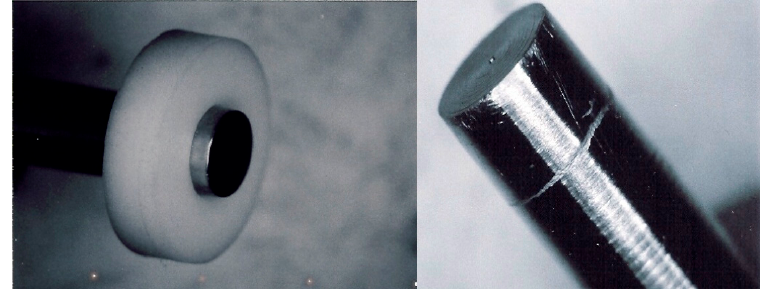
Figure 1. Specific assembly for the crevice corrosion test. Crevice corrosion aspect of the test sample. The sample was mounted in the rotating electrode of the measuring cell (Figure 2).